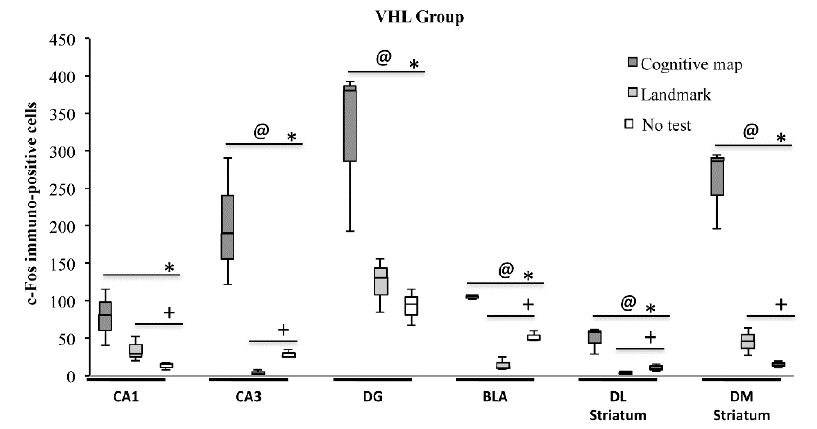
Figure 5. c-Fos activation in hippocampal CA1 and CA3 and dentate gyrus (DG), basolateral amygdala (BLA), dorsolateral (DL) and dorsomedial (DM) striatum exhibited by animals injected with vehicle (VHL) according to the landmark- or cognitive map-related navigational strategy carried out in CHB and in No test condition. Data were analyzed by Kruskal-Wallis test followed by Mann-Whitney U when appropriate. VHL animals which carried out the cognitive map-related navigational strategy showed a number of c-Fos + cells significantly (@, p = 0.05) higher than the VHL animals which carried out landmark-related navigational strategy in all regions of interest but in CA1. Furthermore, VHL animals that carried out the cognitive map-related navigational strategy showed a number of c-Fos + cells significantly (*, p = 0.05) higher than the not tested VHL animals in all regions analyzed. In comparison to not tested VHL animals, the VHL animals that carried out the landmark-related navigational strategy showed a number of c-Fos + cells significantly ( + , p = 0.05) higher in CA1 and DM Striatum, lower in CA3, BLA and DL Striatum and not statistically di ff erent in DG. As regards the AM251 group, no significant di ff erences in c-Fos expression were found in CA1 (H = 3.47, p = 0.18), CA3 (H = 5.60, p = 0.06), DG (H = 3.28, p = 0.19), BLA (H = 2.75, p = 0.25) and